Question: In one sentence, what is this figure communicating?
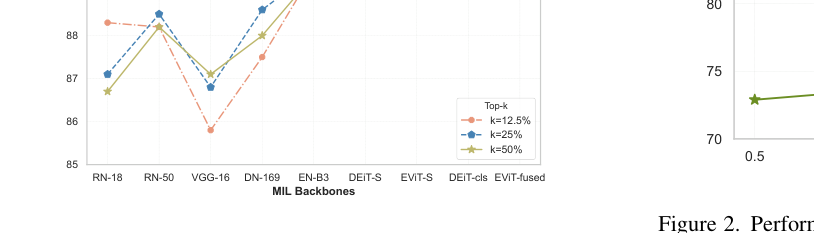
Answer: Search for the optimal k hyperparameter in the instance- level top-k average MIL pooling operator. We explored three val- ues for the hyperparameter: k ≈12.5%, k = 25%, and k = 50%. Our experiments were conducted and evaluated on the validation set of the ISIC 2019 dataset, employing different MIL backbones. The backbones included RN-18, RN-50, VGG16, DN-169, EN- B3, DEiT-S, DEiT-cls (DEiT with the CLS token), EViT-S, and EViT-fused (EViT with the fused embedding). Notably, with EViT backbones, k ≈12.5% resulted in only 9 patches, k = 25% re- tained 17 patches, and k = 50% maintained 34 patches. These results indicate that using more patches in the bag evaluation does not necessarily lead to better performance.